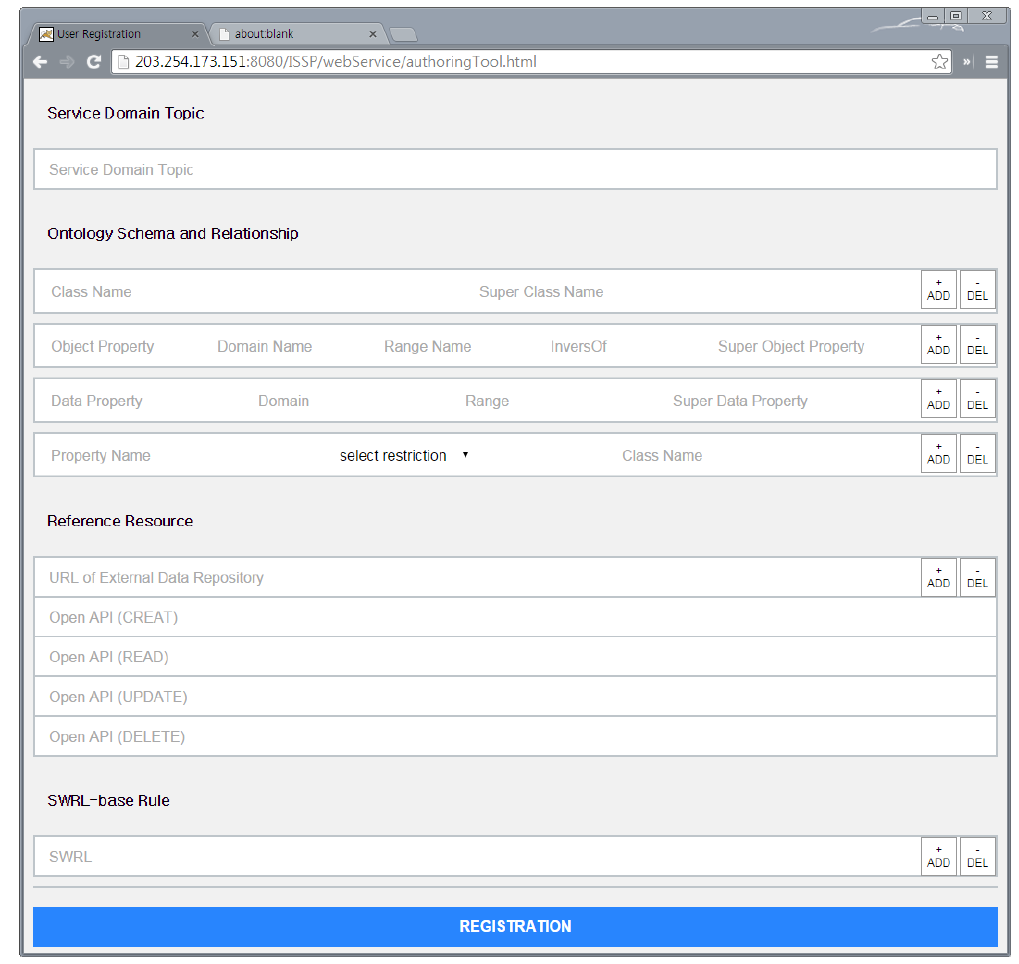
Figure 5. A snapshot of the web-based authoring